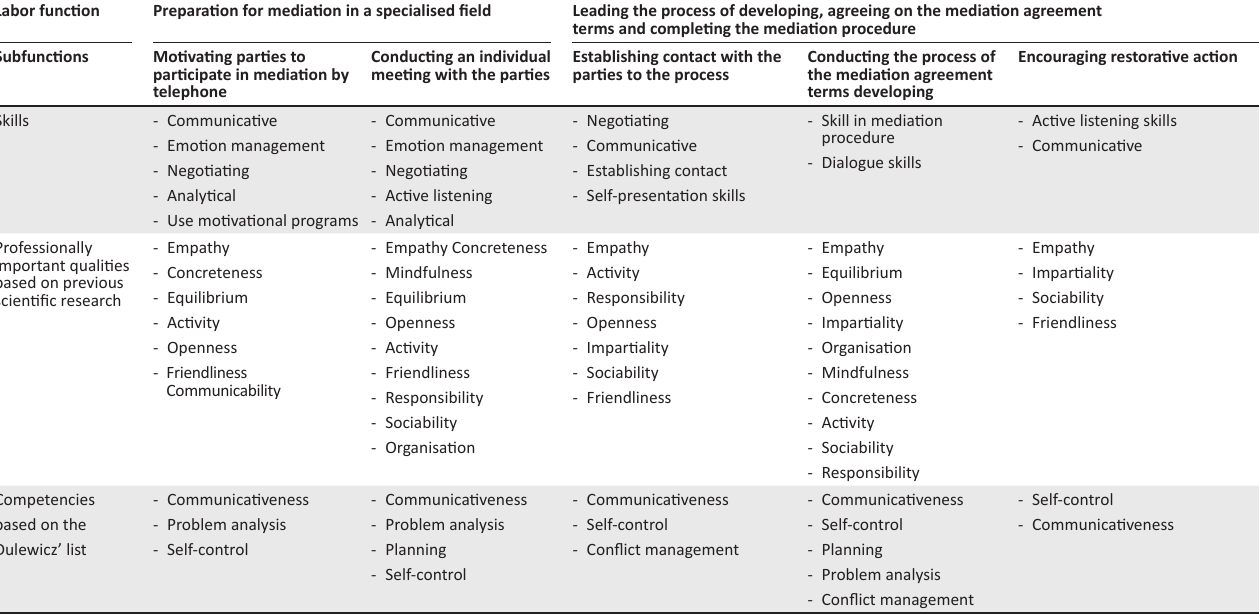
TABLE 1: Determination of mediator’s professional competencies and personal qualities based on the professional standard. Labor function Preparation for mediation in a specialised field